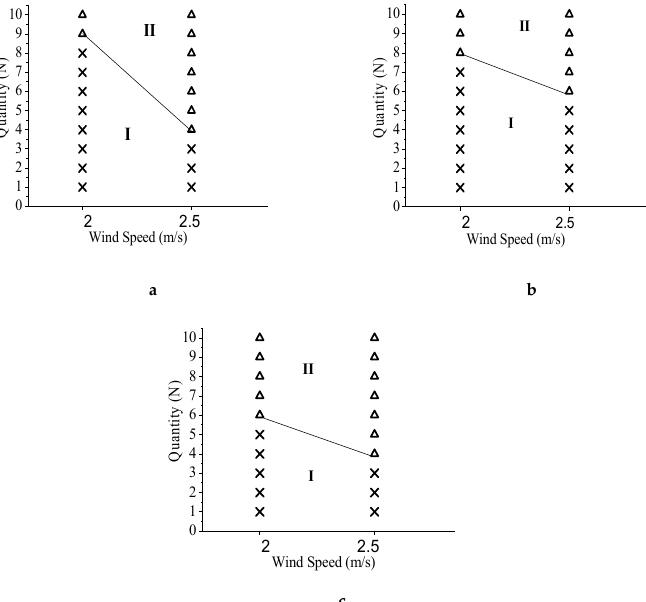
Figure 4. Ignition of samples of plywood ( a ), oriented stand board ( b ) and chipboard ( c ) at different wind speed. (I)—No Ignition zone; (II)—Ignition zone; ∆ —Ignition; ×—No ignition. Analysis of the graphs shows that as wind speed increases, the probability of wood ignition by firebrands of the same size increases. In particular, when the wind speed in- creases from 2 to 2.5 m/s, the minimum number of firebrands with a length L = 40 mm, sufficient to ignite wood, decreases from nine to four; eight to six; six to four firebrands for plywood, OSB and chipboard, respectively. The number of firebrands also affects the ignition of wood. The results coincide with the works of other authors [35]. The interac- tion between firebrand length and firebrand diameter (length times diameter) was also found to be statistically significant. It should be noted that in accordance with the condi- tions of the experiment, the distance between the firebrands after falling on a wood layer, varied from 5 to 50 mm, depending on the firebrand size and their quantity. Figure 5 shows a typical group of images on firebrand ignition of a chipboard sam- ple, on the surface of which glowing firebrands of length 40 mm in the amount of six pieces were discharged.